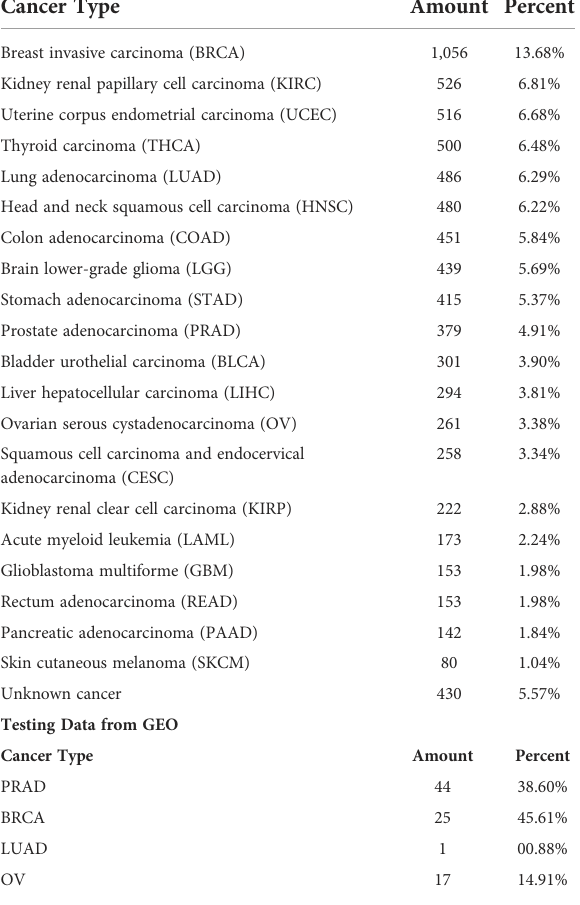
TABLE 1 Data size and